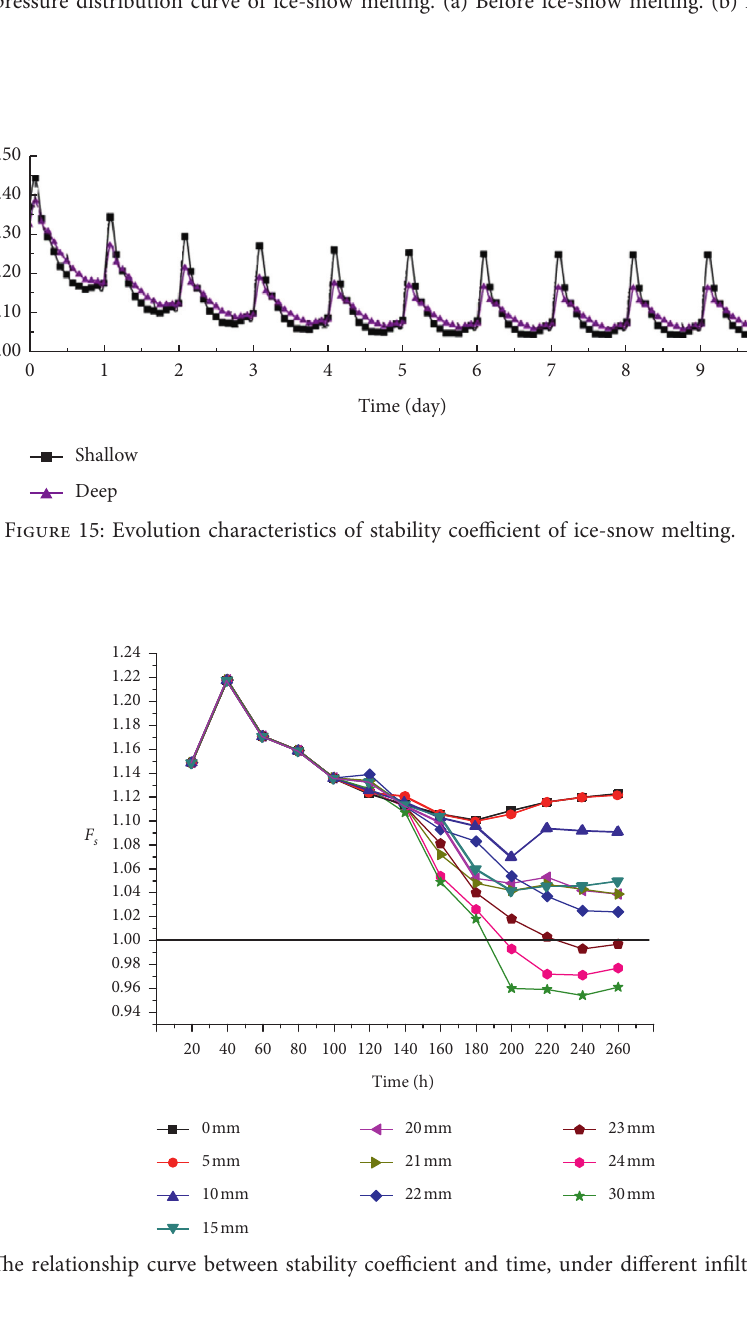
Figure 14: Pore water pressure distribution curve of ice-snow melting. (a) Before ice-snow melting. (b) After ice-snow melting.